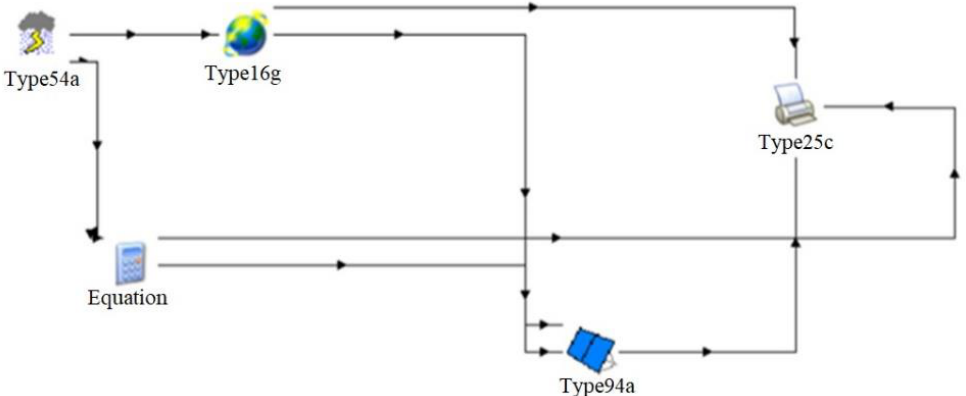
Figure 2. TRNSYS scheme. Table 1. Electrical characteristics of Jakson 250 photovoltaic